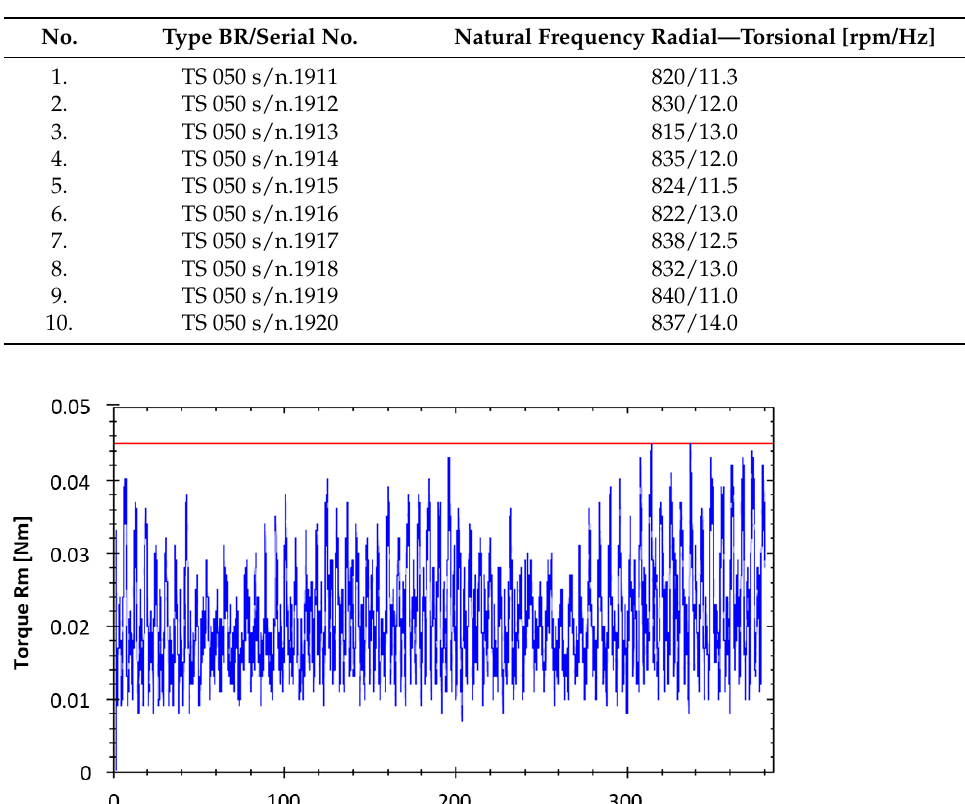
Table 9. Values of natural BR TS 050 frequencies measured after the trial run (configuration B).